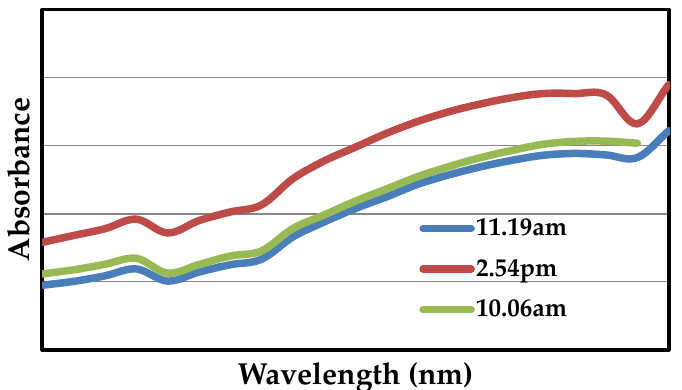
Figure 1. UV-Visible Spectrum of synthesized ZnO NPs using Magnifera indica seed extract.